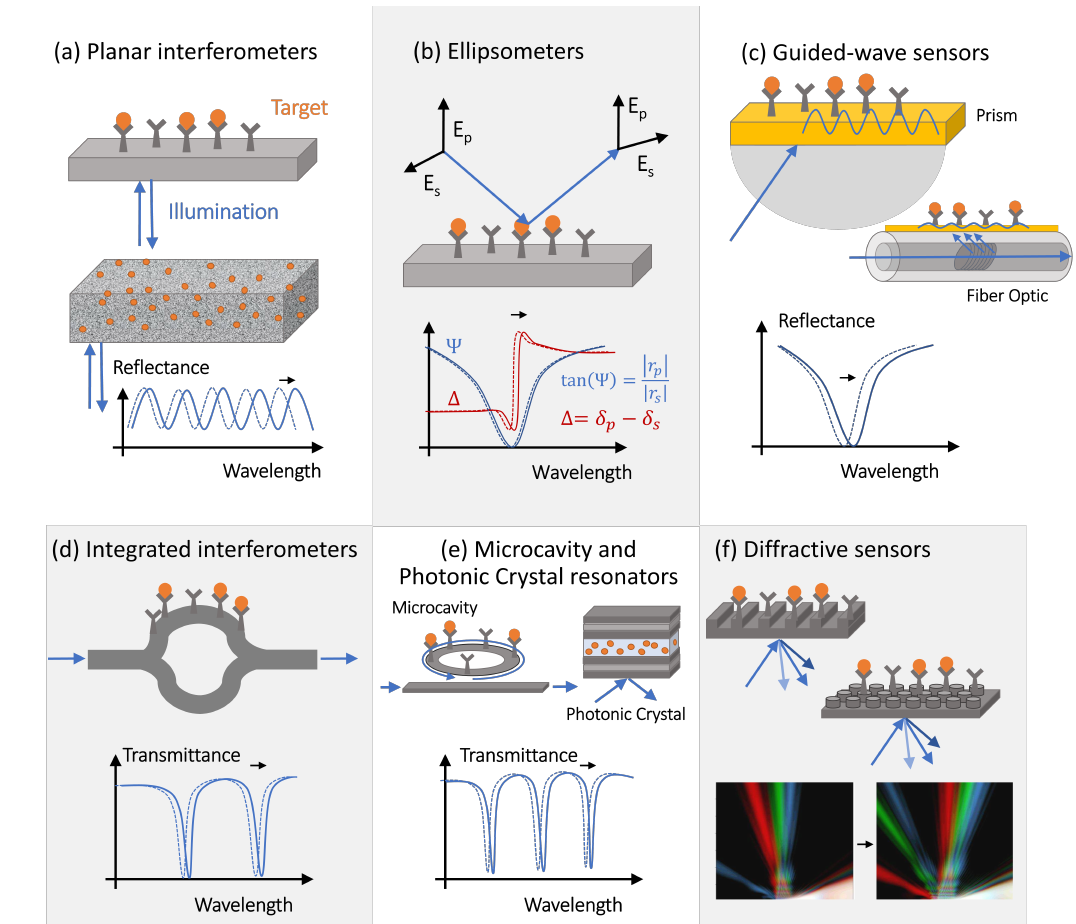
Figure 2. Examples of affinity-type refractometric optical biosensors. ( a ) In planar interferometers, target molecules are captured either by surface-anchored receptors (above) or are absorbed into a permeable layer (below). In both cases, the presence of target molecules shifts the interferometric reflectance pattern, which is a result of the interference of reflected light from the front and back interface of the layer. ( b ) In ellipsometric measurements, both the intensity and phase of reflected light is monitored for s- and p-polarized excitation, enabling higher detection sensitivity at the expense of detector cost and complexity. ( c ) In guided-wave sensors, such as surface plasmon polariton resonance sensors, light is trapped and guided along the surface or within a thin layer, increasing the local electric field near captured target molecules. Light can couple to the guided mode via a prism or, in an optical fiber, light is coupled to the guided mode via a tilted fiber Bragg grating [43]. ( d ) In integrated interferometers, light is split between the sensing arm (above) and a reference arm (below) and recombined to create a transmitted interference spectrum, which shifts due to the target capture. ( e ) Microcavity resonators provide optical amplification by re-circulating optical energy in the form of high-quality trapped modes, such as whispering gallery modes. Light traveling through the bus waveguide interferes constructively or destructively with the microcavity resonant modes, creating narrow transmittance dips in the transmission spectrum whose spectral positions can be monitored for detection. Here, a microring resonator is shown. Defects in photonic crystals can also form resonators, such as the illustrated 1-dimensional photonic crystal structure with a defect layer in the middle. The defect layer creates a resonance in the reflectance spectrum of the structure, which can track with target concentration [55]. Here, the transmittance spectrum is shown for the microring cavity, while the transmittance of the photonic crystal would depend upon the number of resonant modes supported in the defect layer. ( f ) In diffractive-type sensors, incident light is diffracted in certain angles depending on the surface coverage of target molecules. The angle-specific intensity of reflectance can be monitored to measure the concentration of target